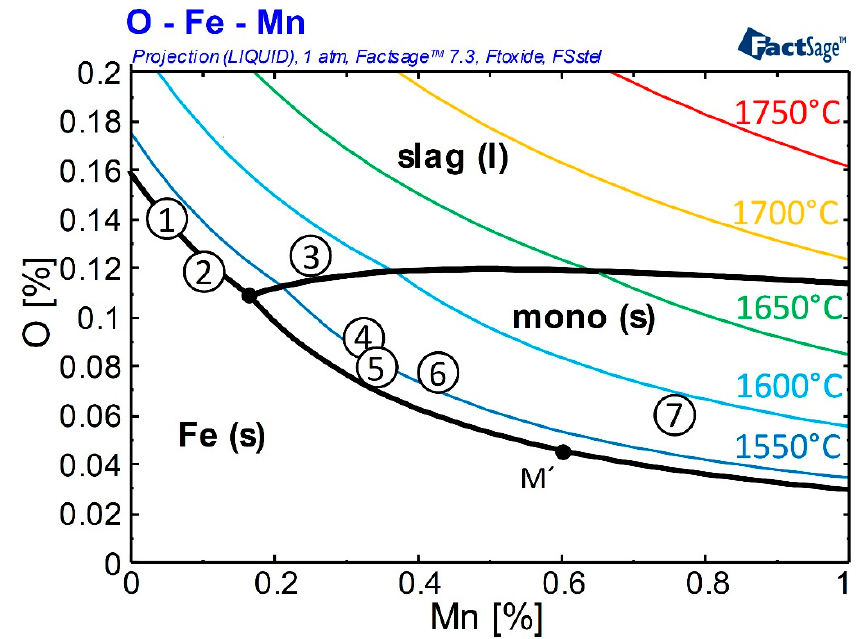
Figure 6. Fe-Mn-O system M’ [32] and positions of Samples 1–7.